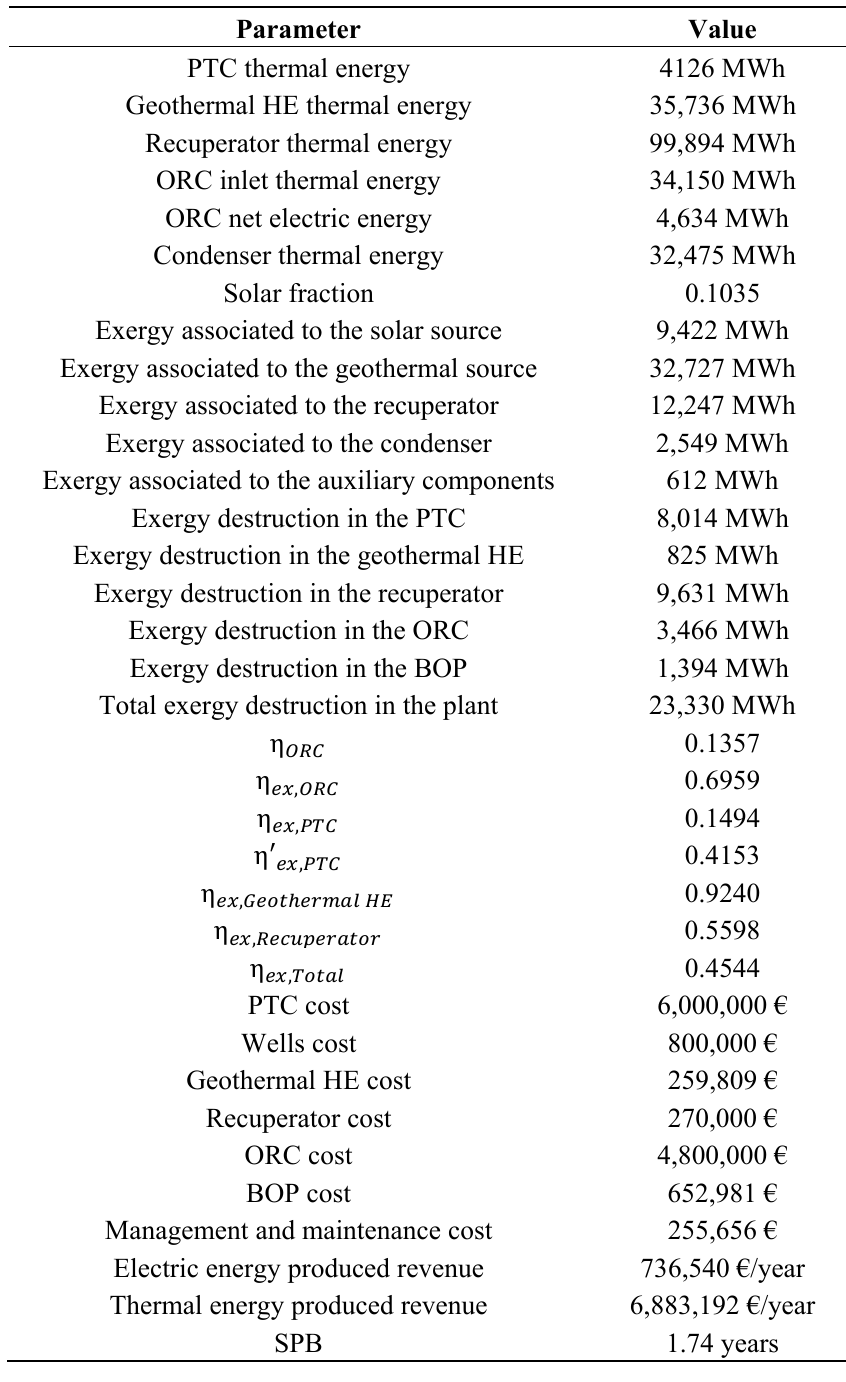
Table 9. Annual performance of the